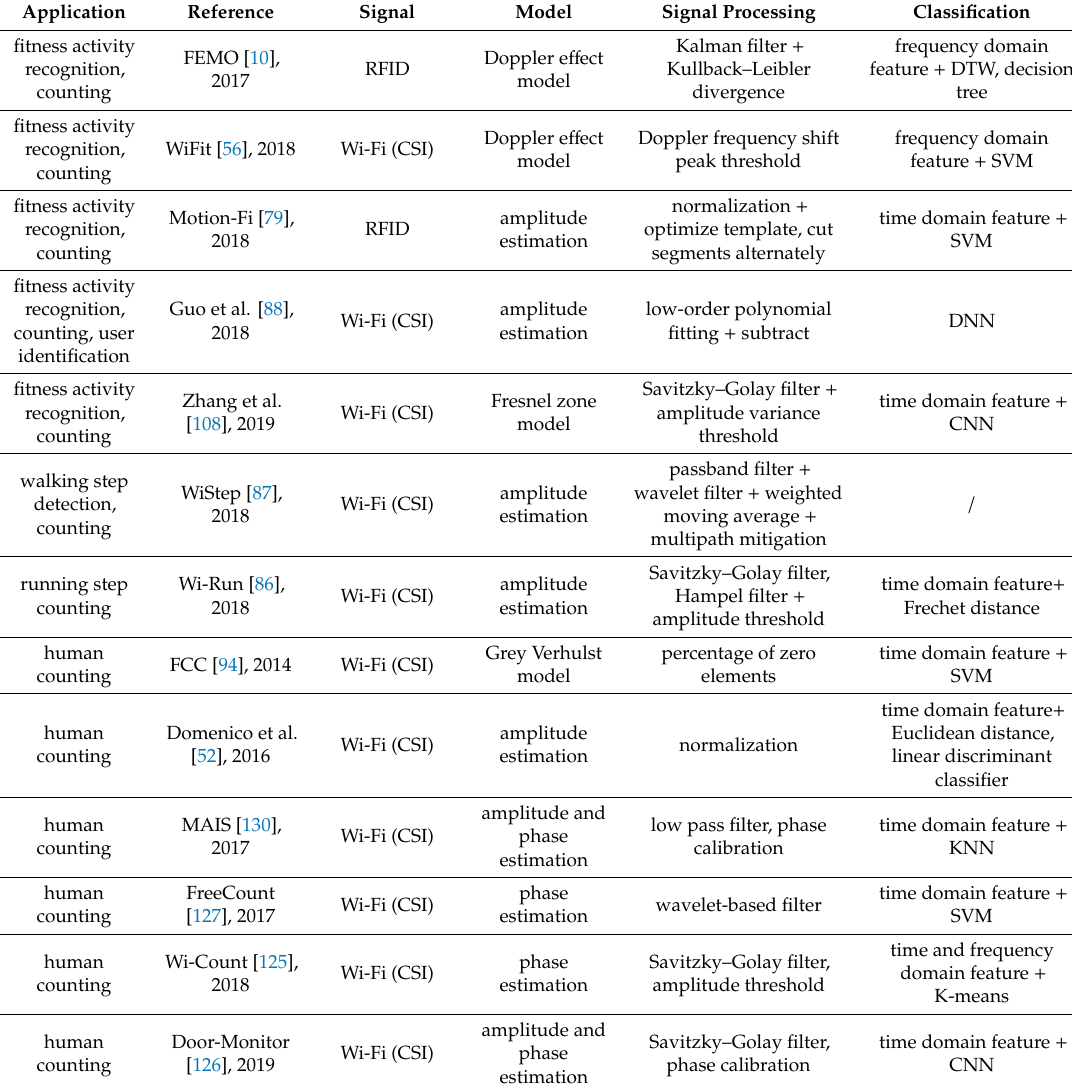
Table 11. Summary of wireless sensing applications: